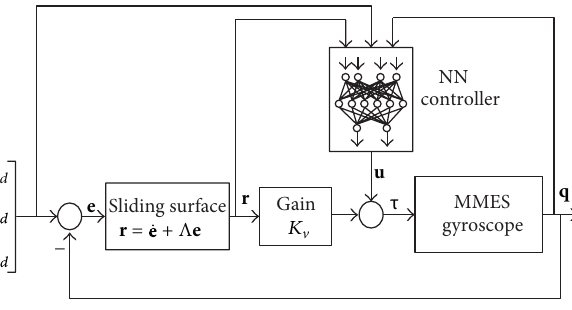
Figure 3: Adaptive NN control structure.